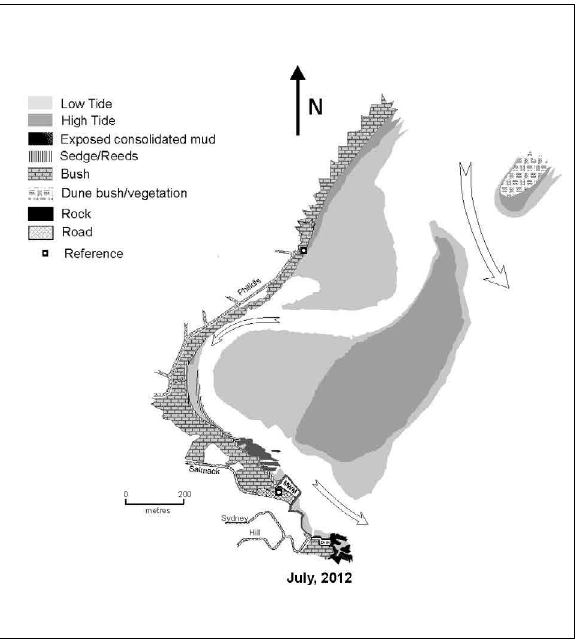
Figure 12: Keurbooms Estuary sediment structures after the breach of the new mouth in the northeast. Ebb current flows are